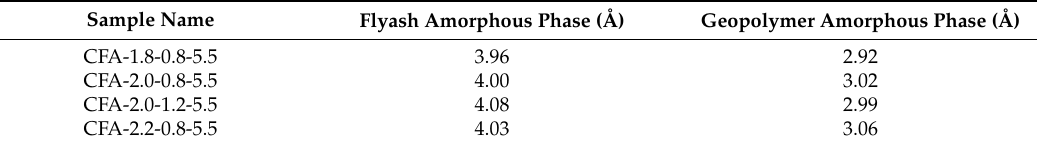
Table 3. The refined d-spacings of the flyash and geopolymer amorphous phase peaks. The geopolymer amorphous phase peak positions are smaller than found for the metakaolin geopolymer [33] which were between 3.15 and 3.22 Å. The flyash amorphous phase peak position was allowed vary between samples in the